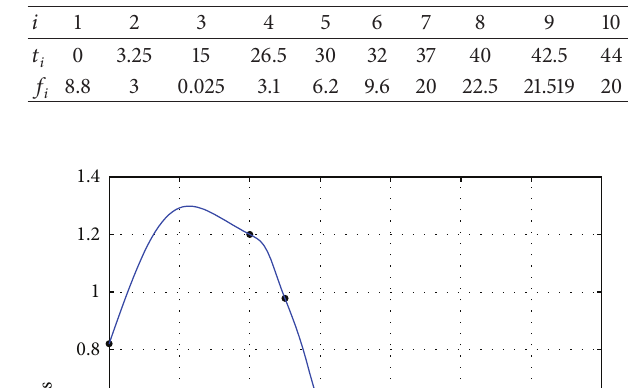
Table 1: A 2D positive dataset. Table 2: A 2D positive dataset.